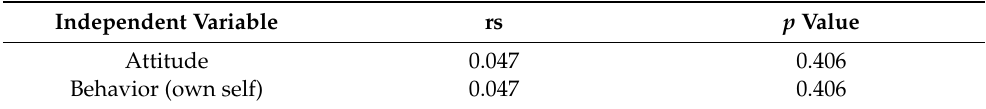
Table 6. Results of association between students’ attitudes and behavior (own self) towards academic dishonesty during online